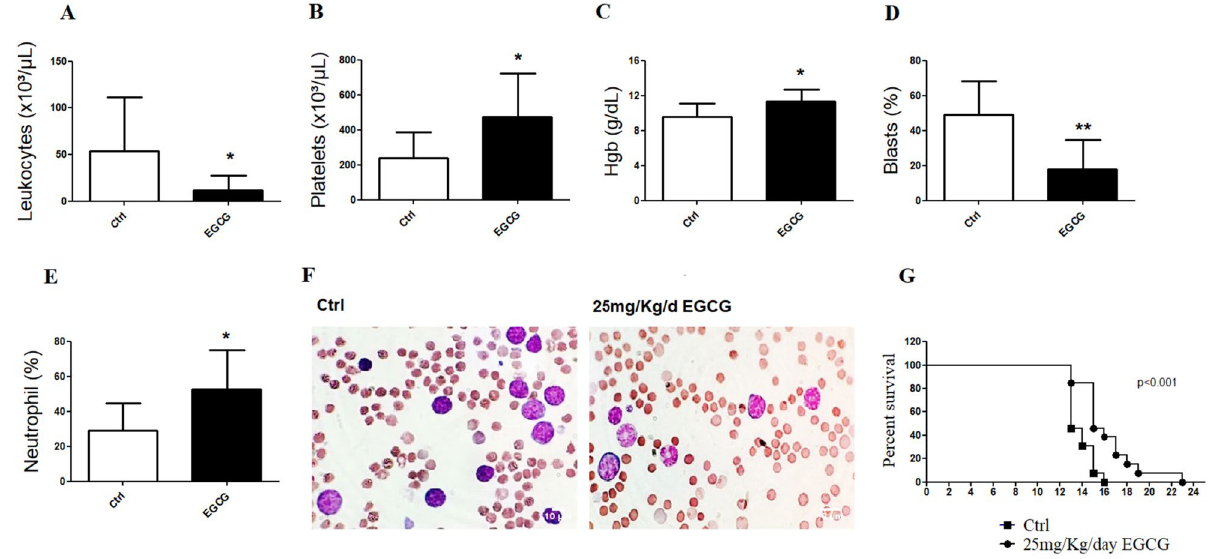
Figure 1. Haematological data of PML/RARα mice submitted to EGCG treatment. At the end of treatment (16th day) with EGCG (25 mg/kg/day i.p.) or vehicle (Ctrl), PML/RARα mice were bled from the retro-orbital plexus. EGCG induced a reduction of leukocytes ( A ), and an increase of platelets ( B ) and haemoglobin levels ( C ) using the CELL-DYN Emerald Haematology System counter. A reduction of blasts percentage ( D ) and an increase of neutrophils percentage ( E ) were also observed in the differential counts obtained from peripheral blood Leishman–Wright–Giemsa-stained smears. Representative images of peripheral blood Leishman– Wright–Giemsa-stained smears (100 ×) of PML/RARα mice treated with vehicle (Ctrl) or EGCG ( F ). EGCG treatment also increased the survival of PML/RAR mice ( G ). Statistical significance (Student t test) is indicated, as follows: * P < 0.05; ** P < 0.01. For survival curve statistical significance (Log-Rank; Mantel-cox test) is indicate, as follow: P <